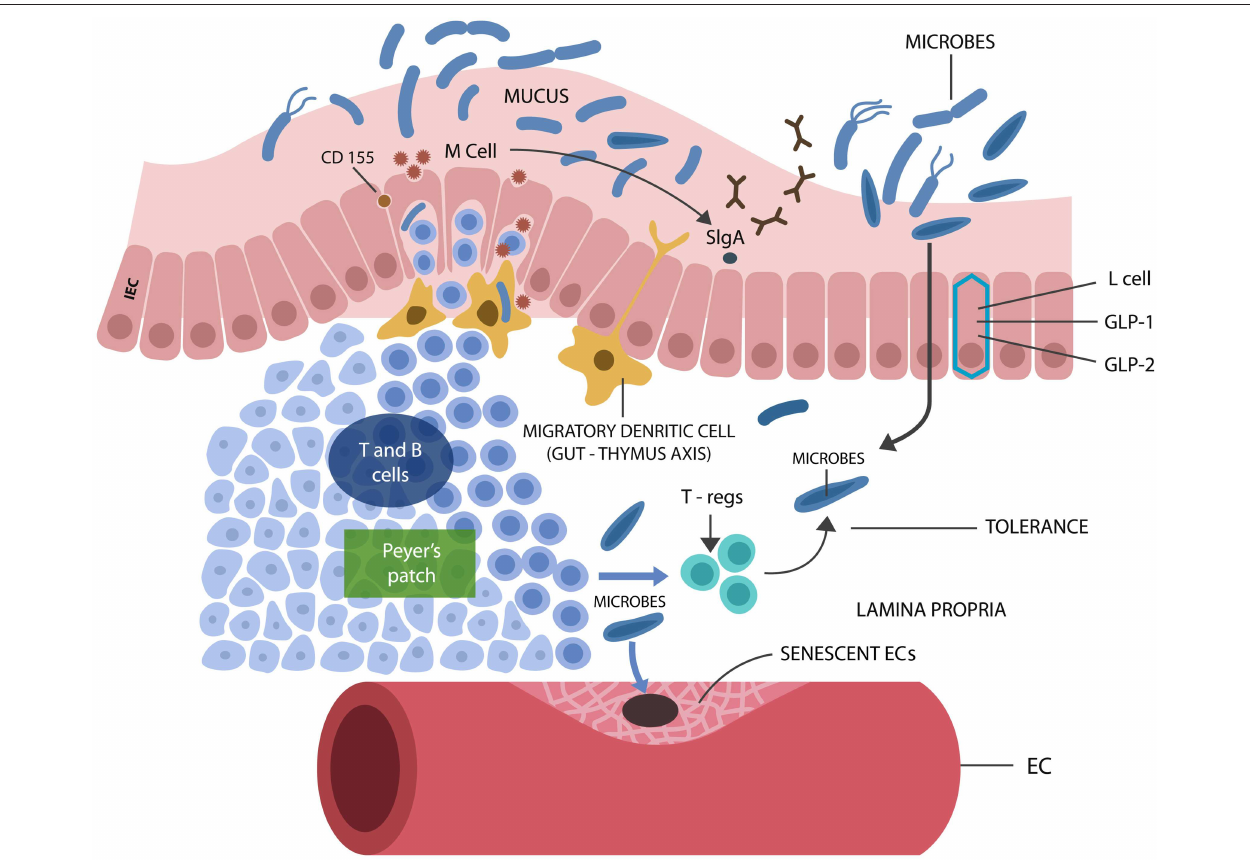
FIGURE 2 | M cells interact with luminal microbes, introducing microbial antigens to the T and B cells, engendering tolerance via Tregs and IL-10 secretion. M cells promote the expression of the mucosal protector, SIgA. L cells synthesize IECs protecting biomolecules GLP-1 and GLP-2. Senescent ECs cause endothelial disruption, allowing pathogens into the circulatory system, from where they find their way into the